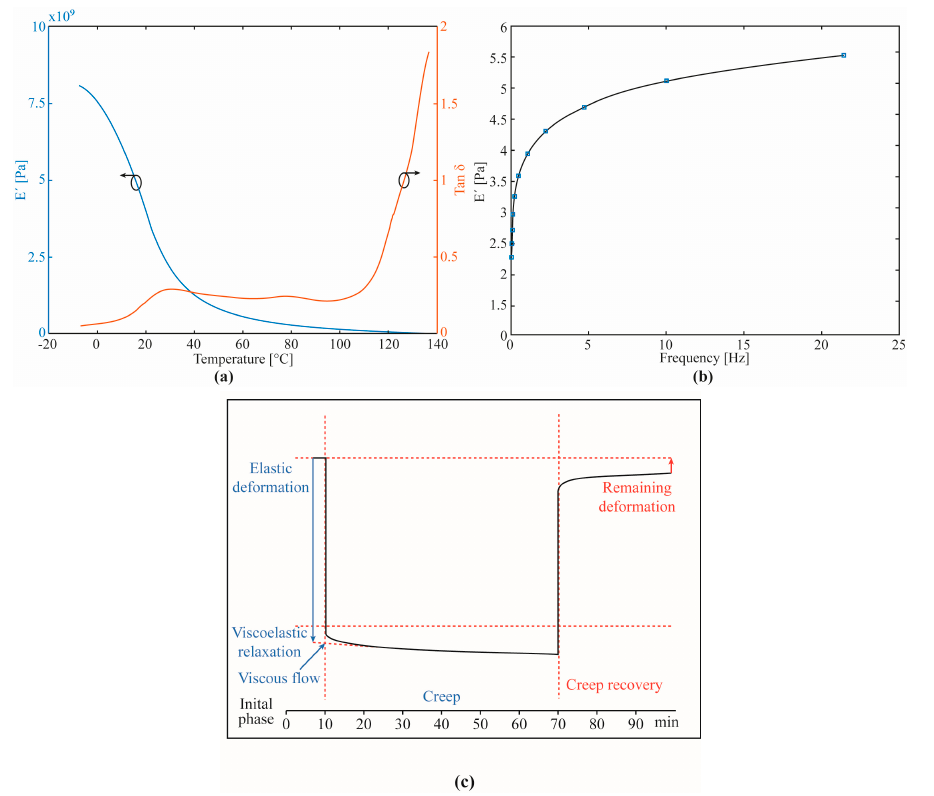
Figure 5. Typical response curves from POFs. ( a ) Temperature response with storage modulus (E’) and loss factor (tan δ ), ( b ) Frequency response, and ( c ) Creep response indicating the viscous and elastic part of the polymer response.